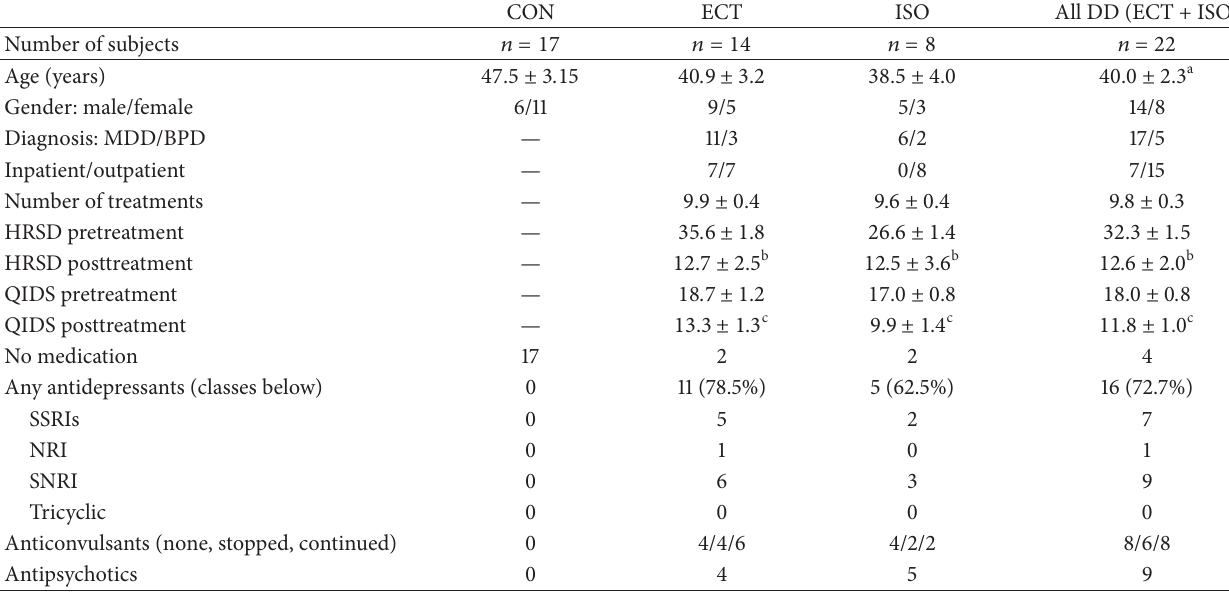
Table 1: Demographic and medical data for controls (CON) and depressive disorder (DD) patients at